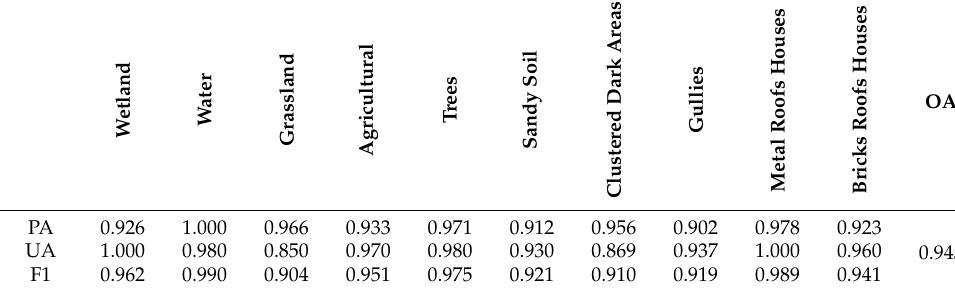
Table 8. Error matrix of object-bases classification of Tour è along the Sirba River